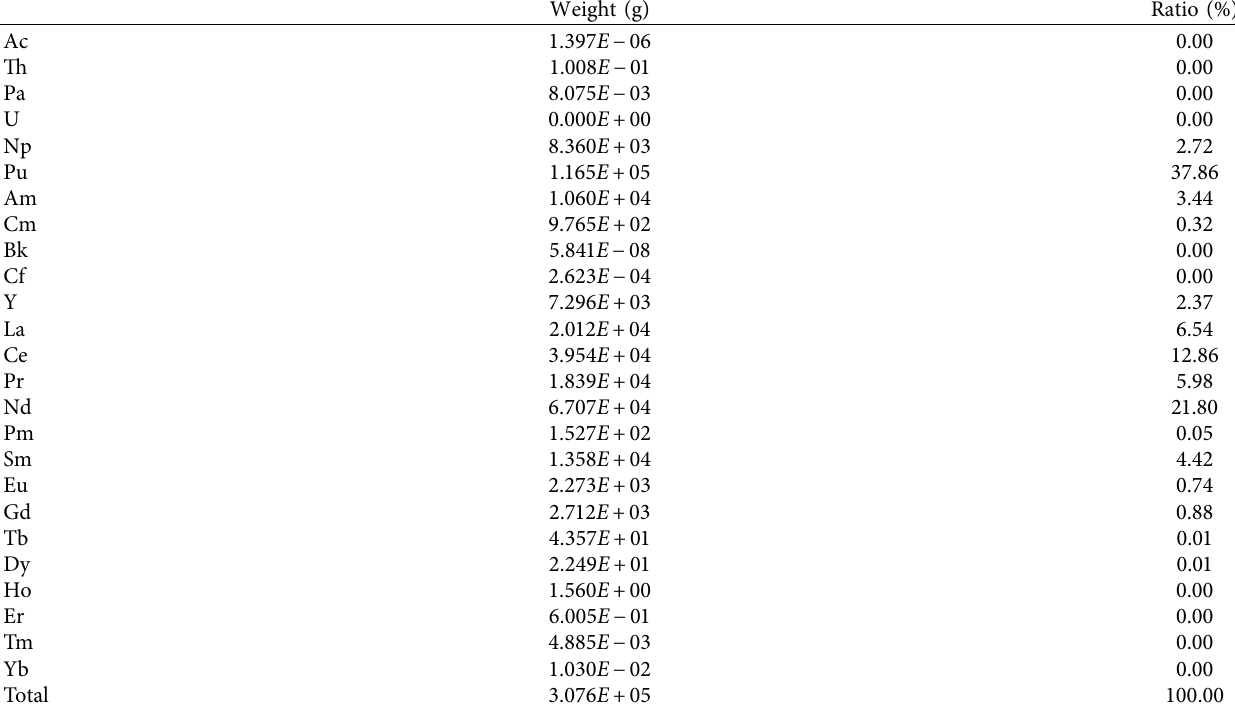
Table 9: Amount of TRU/RE nuclide contained in 10 tons of spent nuclear